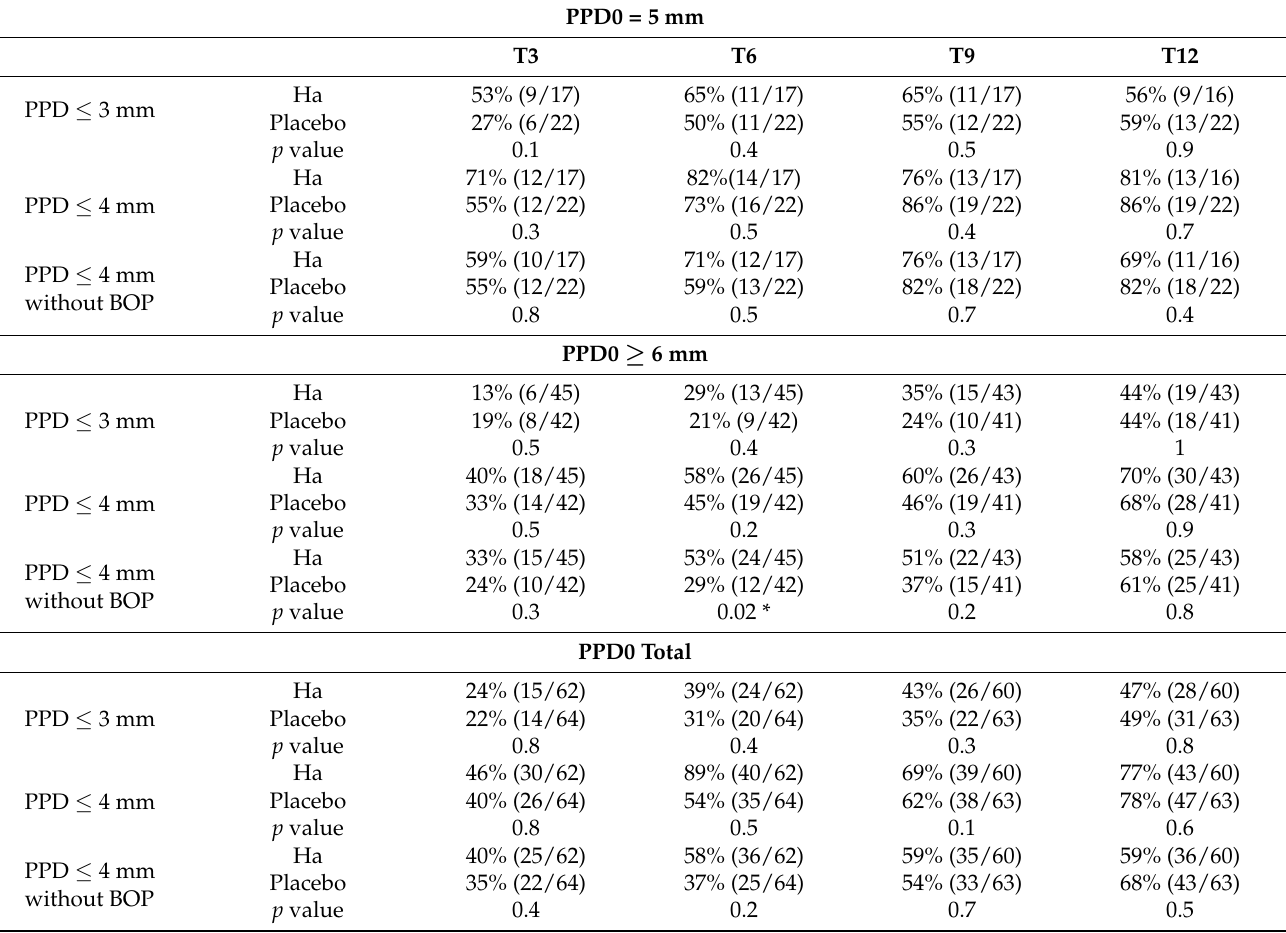
Table 2. Percentage of completely closed pockets (PPD ≤ 3 mm), shallow pockets (PPD ≤ 4 mm) and percentage of shallow pockets with lack of bleeding on probing (BOP) achieved in both treatments based on the values of PPD at T0